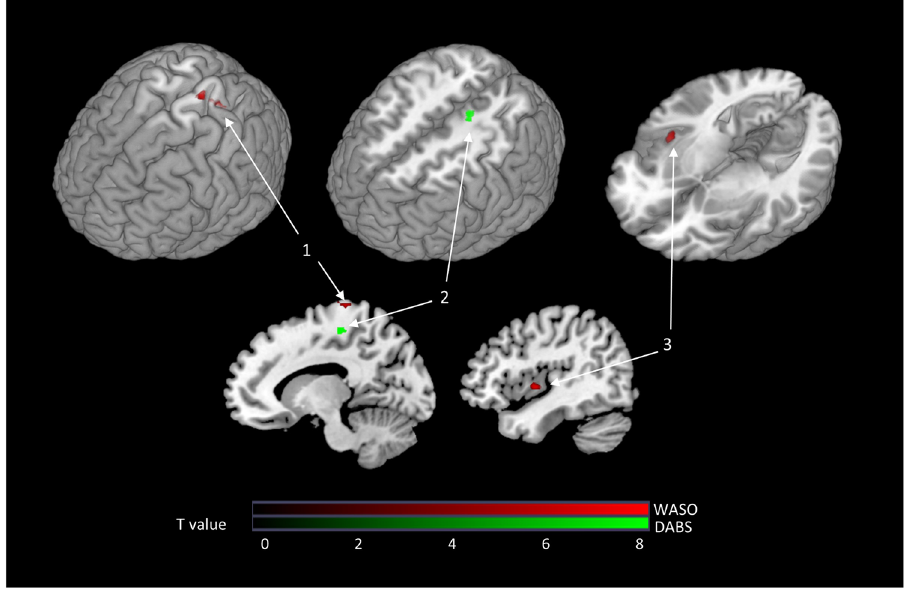
Figure 5. Brain areas where changes in the BOLD response to SS after CBT-I correlated significantly with clinical improvement in insomnia after CBT-I. 1: Left superior paracentral cortex. 2: Left inferior paracentral cortex. 3: Right insula. ( A ) Decrease in WASO after CBT-I was correlated with a reduction in the left superior paracentral BOLD response to SS. ( B ) DBAS score decrease after CBT-I correlated with a decrease in the left inferior paracentral BOLD response to SS. ( C ) WASO decrease after CBT-I correlated with a decrease in the right insular BOLD response to SS. Note: The BOLD response to SS was calculated by subtraction of the BOLD response to NS from the BOLD response to SS